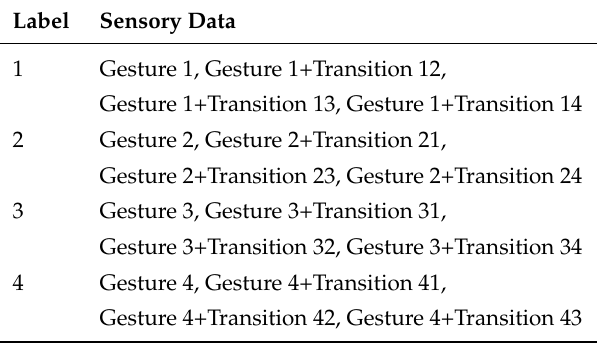
Table 2. Labels associated with the sensory data considered in this